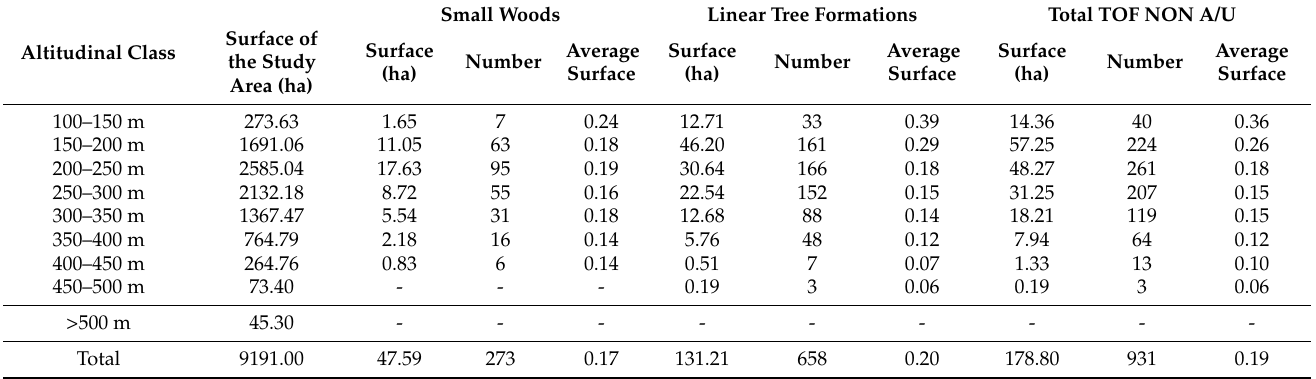
Table 4. Variation of the average surface of TOF NON A/U according to the different altitudinal classes.